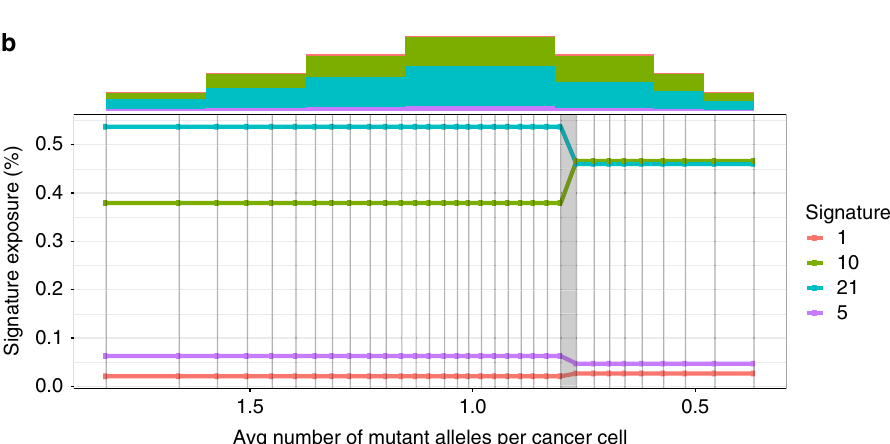
Fig. 4 TrackSig reconstruction examples. a Simulated data was generated with two clusters and clonal neutral mutations at read depth 100. TrackSig incorrectly places a changepoint before a cluster of neutral mutations from the clonal lineage near the VAF detection limit. However, because the signature activities match those in the clonal cluster, this error could be detected and corrected in post-processing. b Simulated data was generated with two clusters at read depth 10. TrackSig correctly identi fi es one changepoint. Although the simulation contains two clusters, there is only a single mode of CCF, thus making CCF-cluster-based detection of subclones impossible. However, the histogram on top shows that there are differences in mutation type distributions between the left and right tails, permitting TrackSig to correctly identify a changepoint. Both fi gures use an expanded x -axis that shows the whole spread of estimated CCF, this is indicated with a change in the x -label